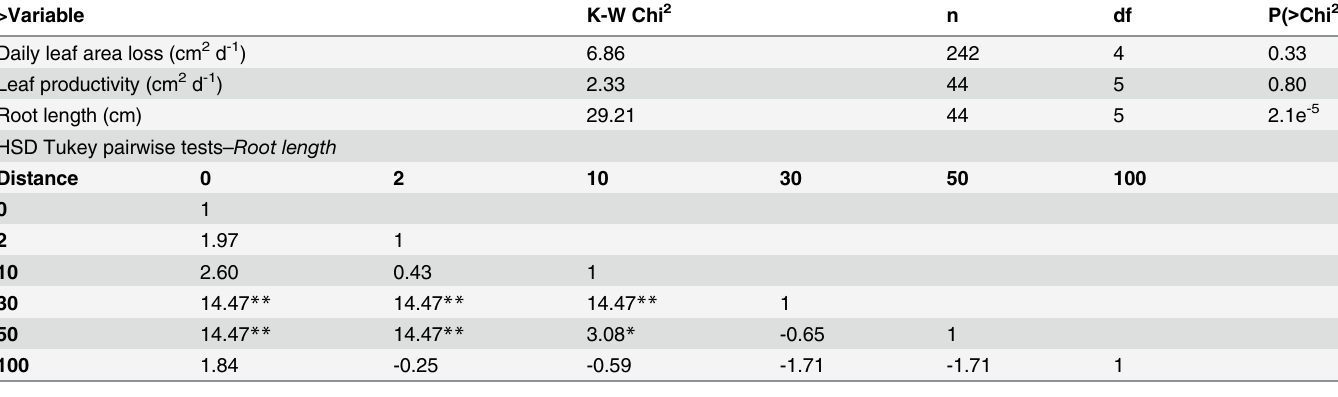
Table 2. Kruskal-Wallis Chi square analysis (and Tukey HSD pairwise comparisons) comparing daily leaf area loss, leaf productivity (after 6 months) and root length (after 6 months) by distance from seagrass meadow